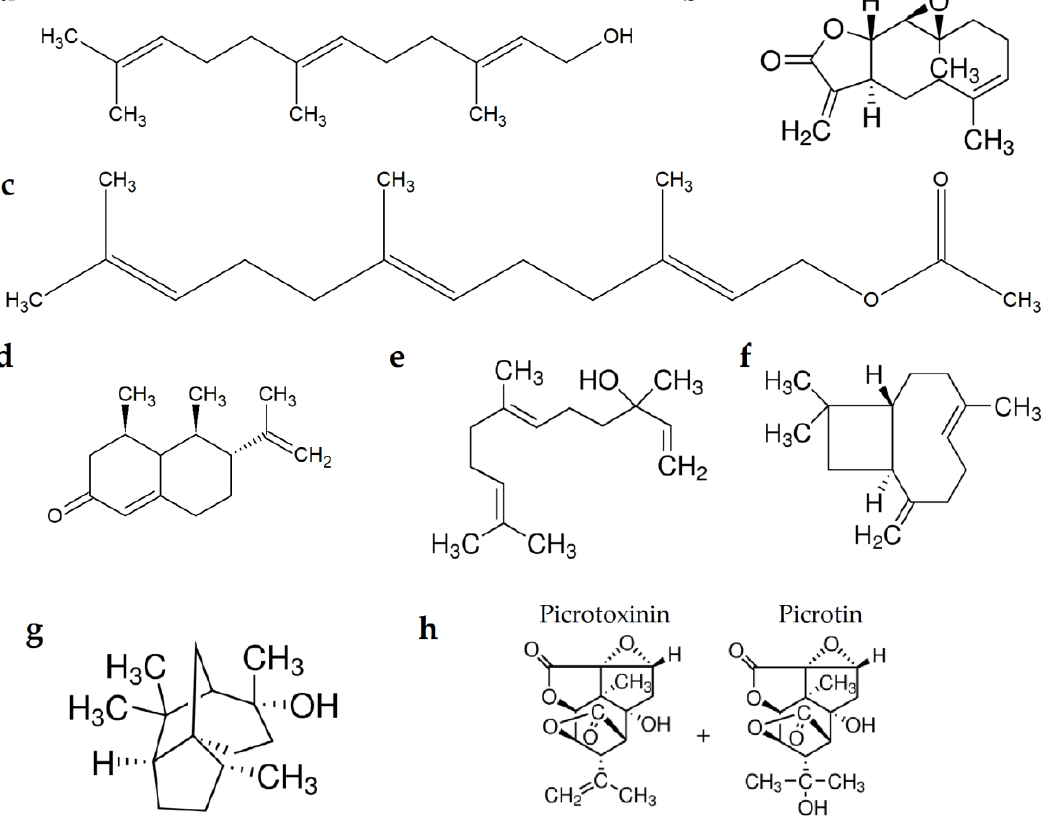
Figure 2. Structures of studied sesquiterpenes, ( a ) Farnesol, ( b ) Parthenolide, ( c ) Farnesyl acetate, ( d ) ( + )-Nootkatone, ( e ) Nerolidol, ( f ) β -Caryophyllene, ( g ) ( + )-Cedrol, and ( h ) Picrotoxin